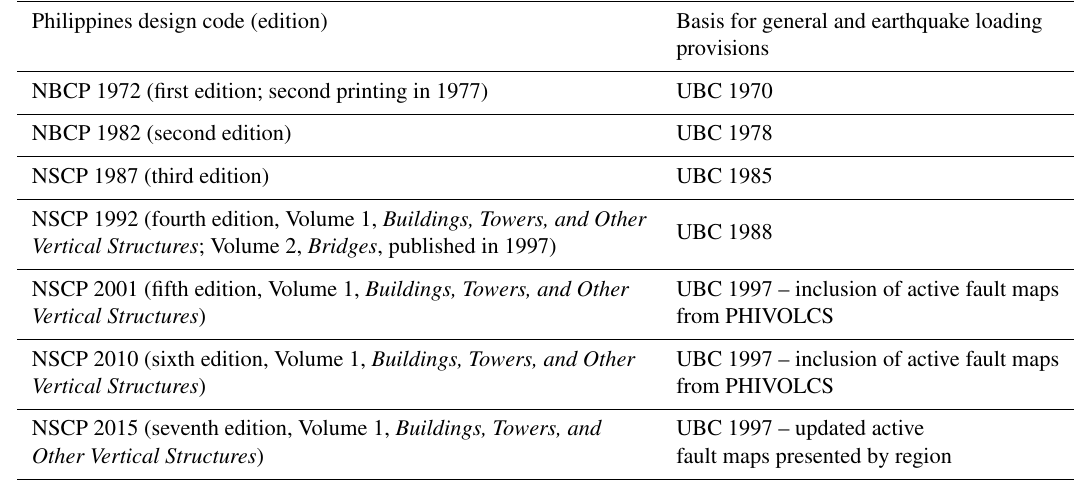
Table 1. Evolution of seismic codes in the Philippines. NBCP is National Building Code of the Philippines; NSCP is National Structural Code of the Philippines; PHIVOLCS is Philippine Institute of Volcanology and Seismology.